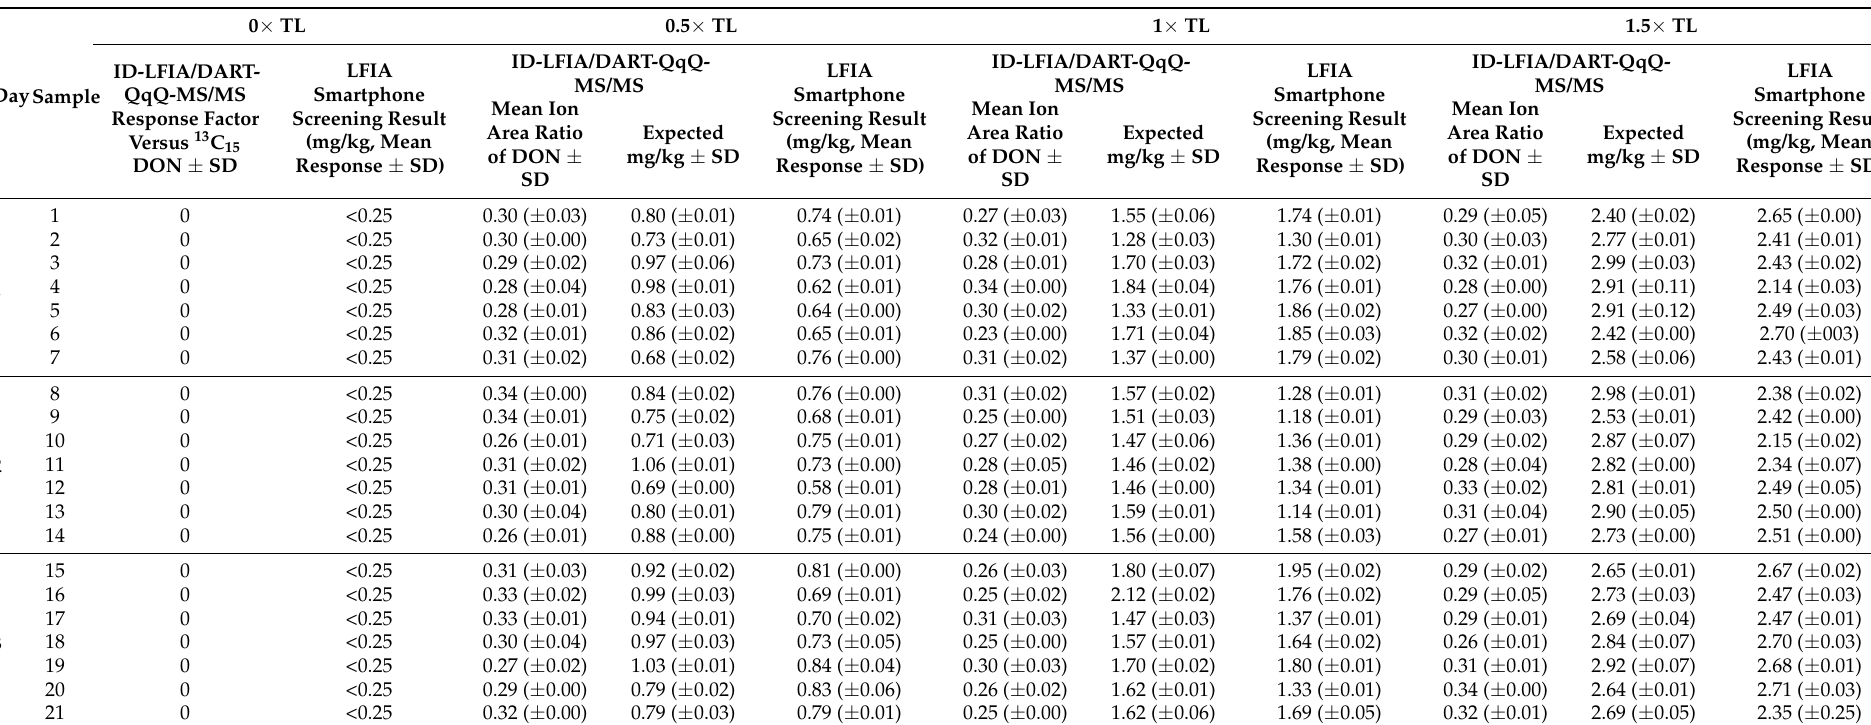
Table 2. Results from ID-LFIA/DART-QqQ-MS/MS analysis and the respective LFIA smartphone screening of 21 validation blank and spiked wheat samples at three different target levels and performed on three different